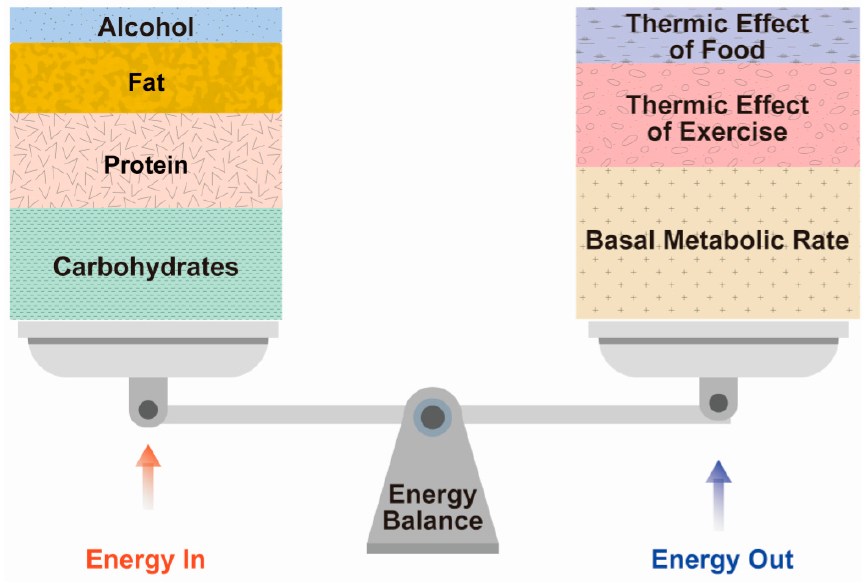
Figure 2. Energy balance between energy in and energy out.